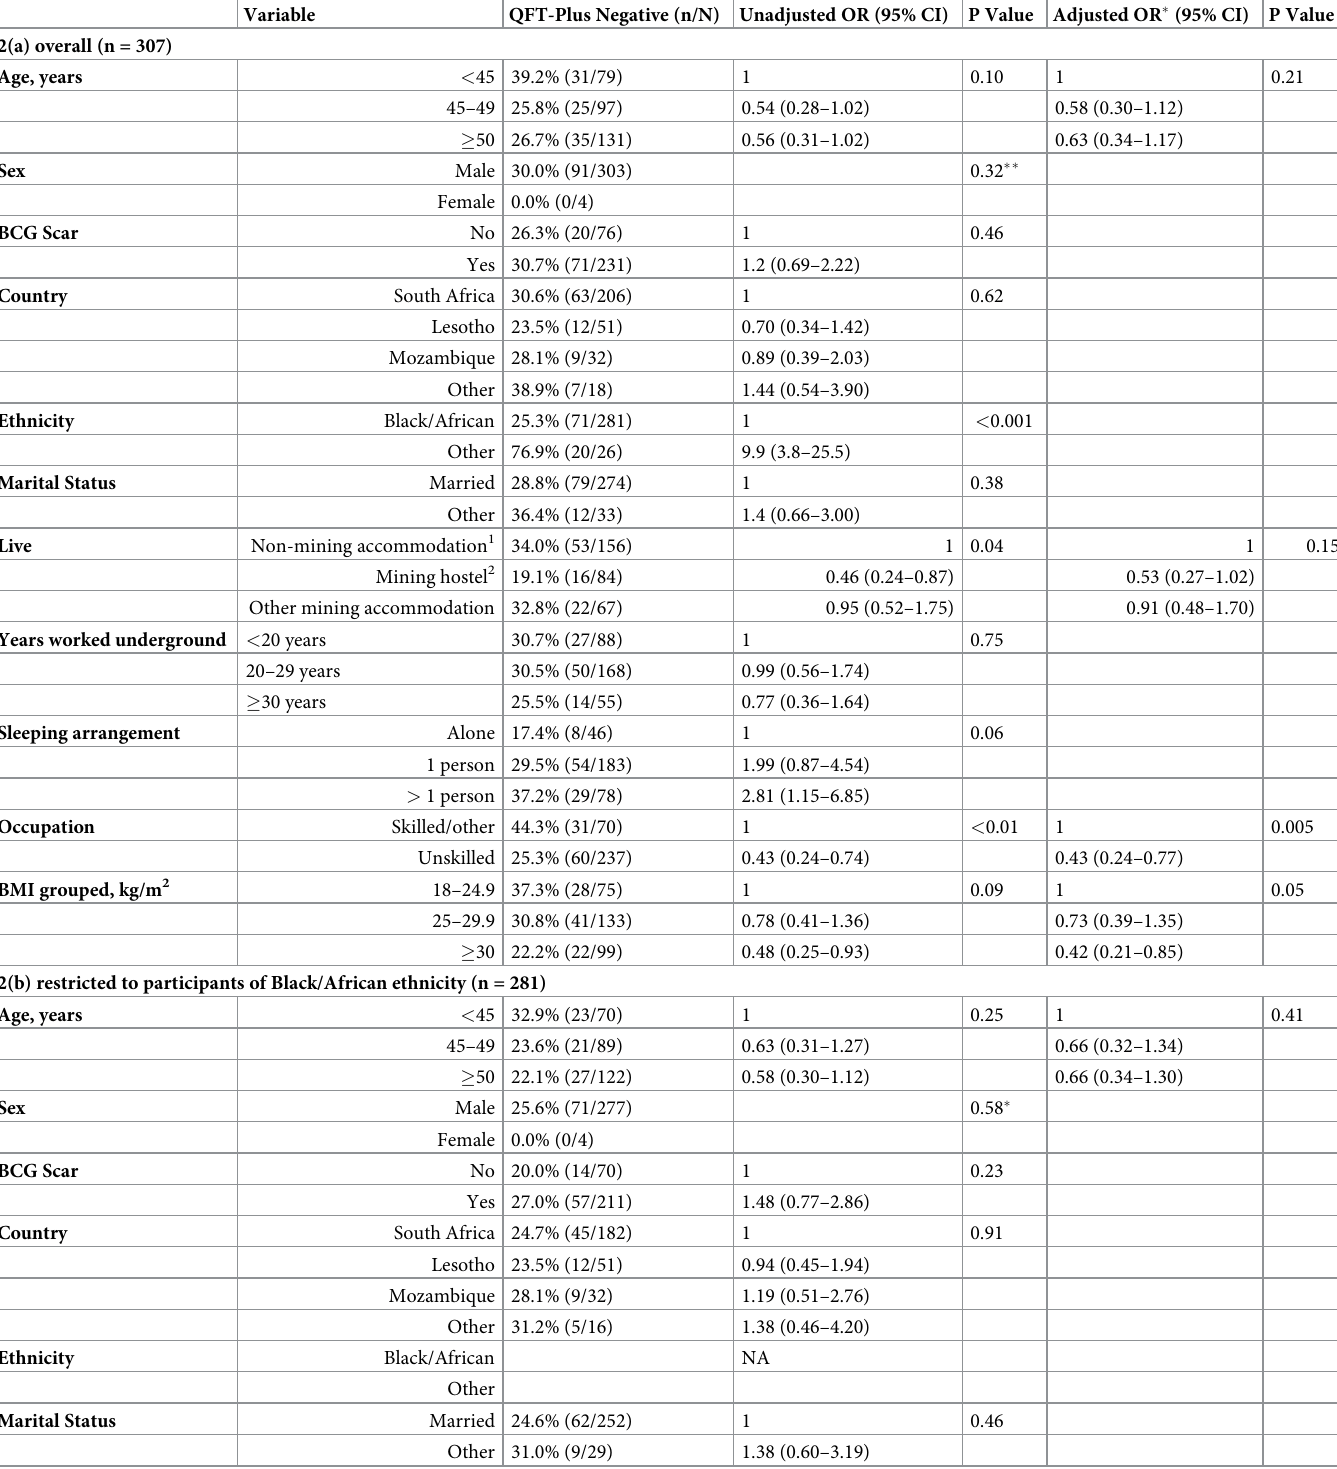
Table 2. Factors associated with being TB uninfected as defined by being QFT-Plus negative, among miners attending for annual medical examination: 2(a) overall (n = 307); and 2(b) restricted to participants of Black/African ethnicity (n = 281).